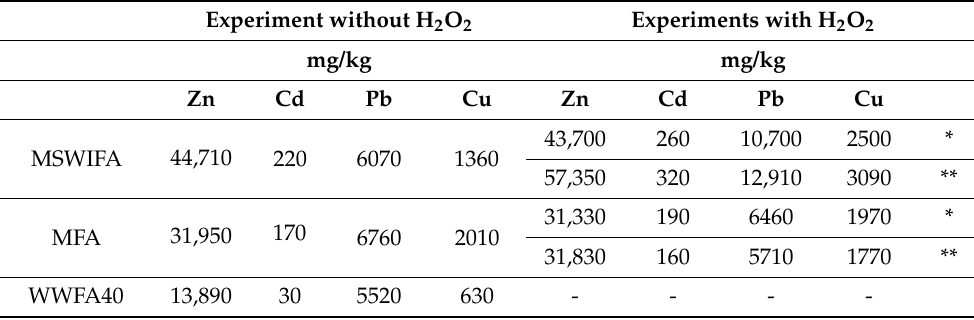
Table 5. Heavy metal concentrations of the different ashes investigated in industrial-scale leaching experiments. The concentrations for the experiments with 40 and 60 L/t H 2 O 2 are indicated with * and **, respectively. Experiment without H 2 O